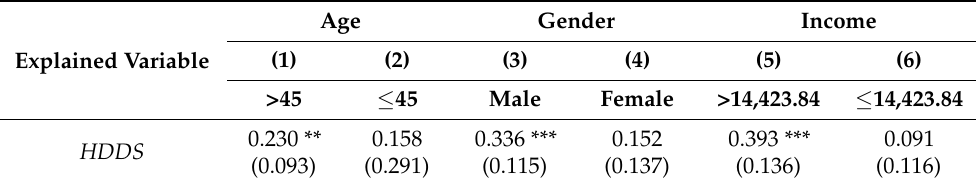
Table 9. Heterogeneity